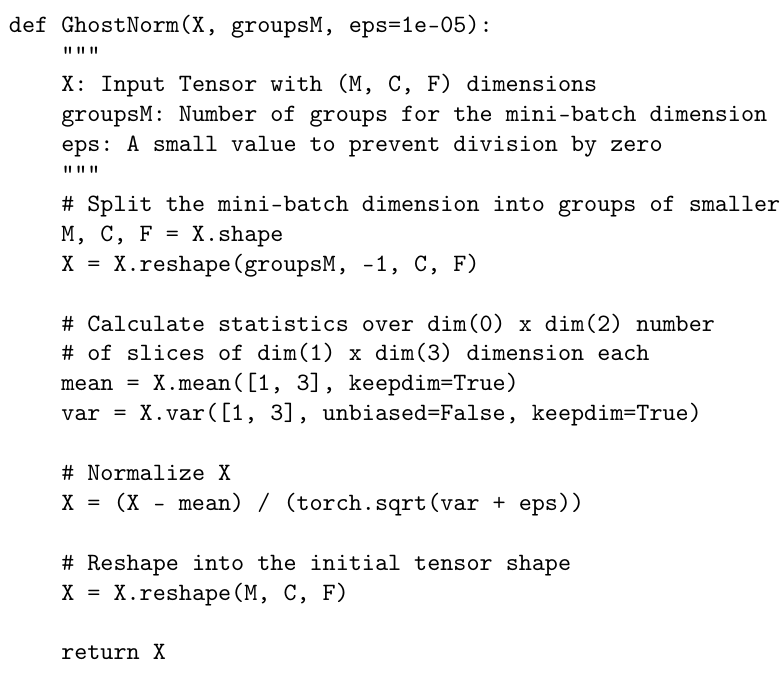
Figure A1. Python code for GhostNorm in